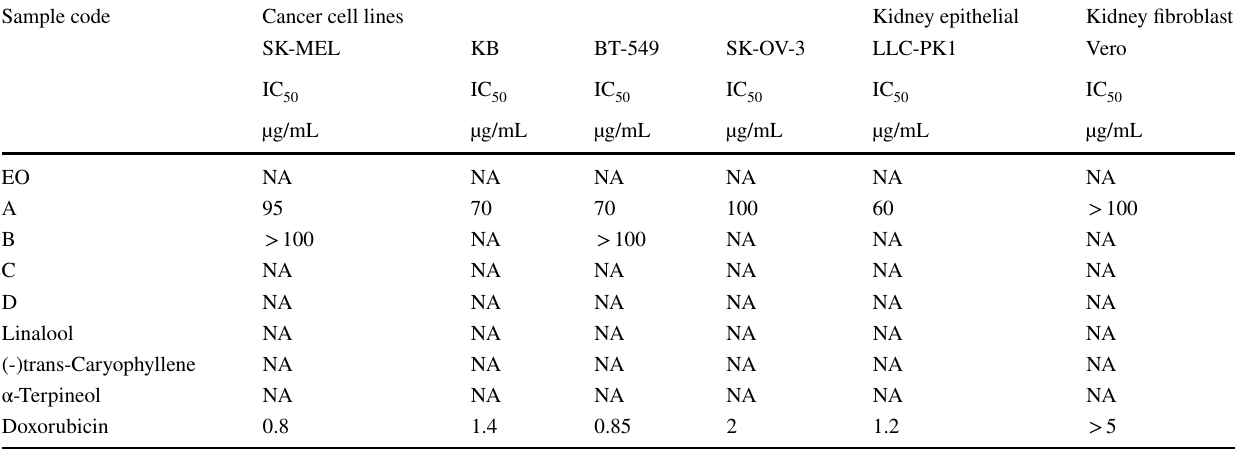
S. ceratophylla EO, polar and non-polar extracts and pure compounds 50 ) of